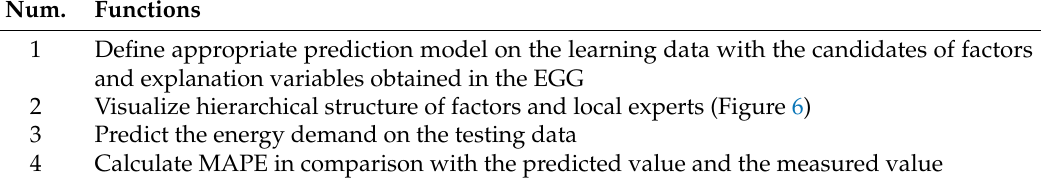
Table 1. Function list of the EP tool.